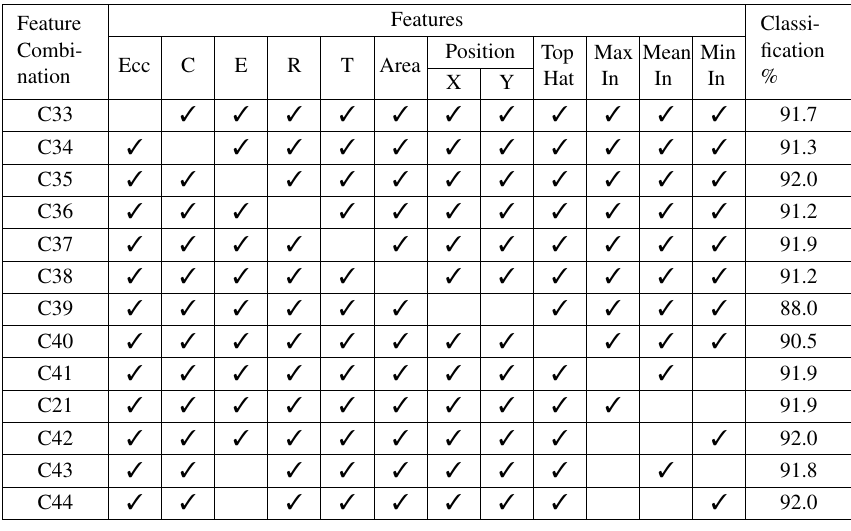
Table 5. Classification rate of RBF classifiers with different feature combinations. There are three parameters which play a central role in the design of the pairing algorithm Distance between the two components in the image.